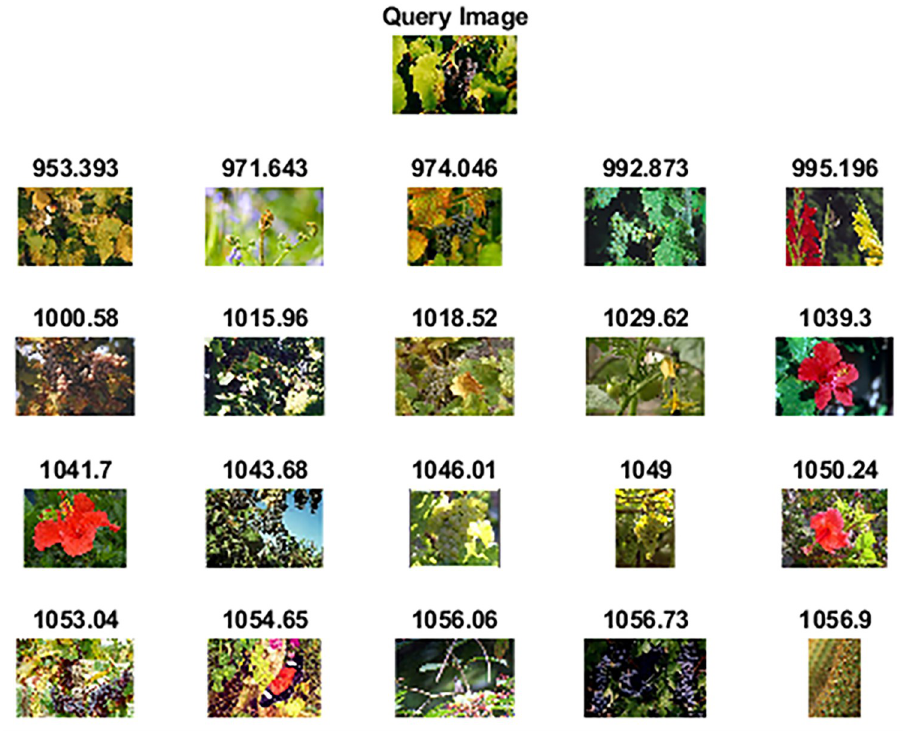
Fig 20. Top-20 retrieved images according to the query image of the Caltech-256 dataset (class: Grapes).